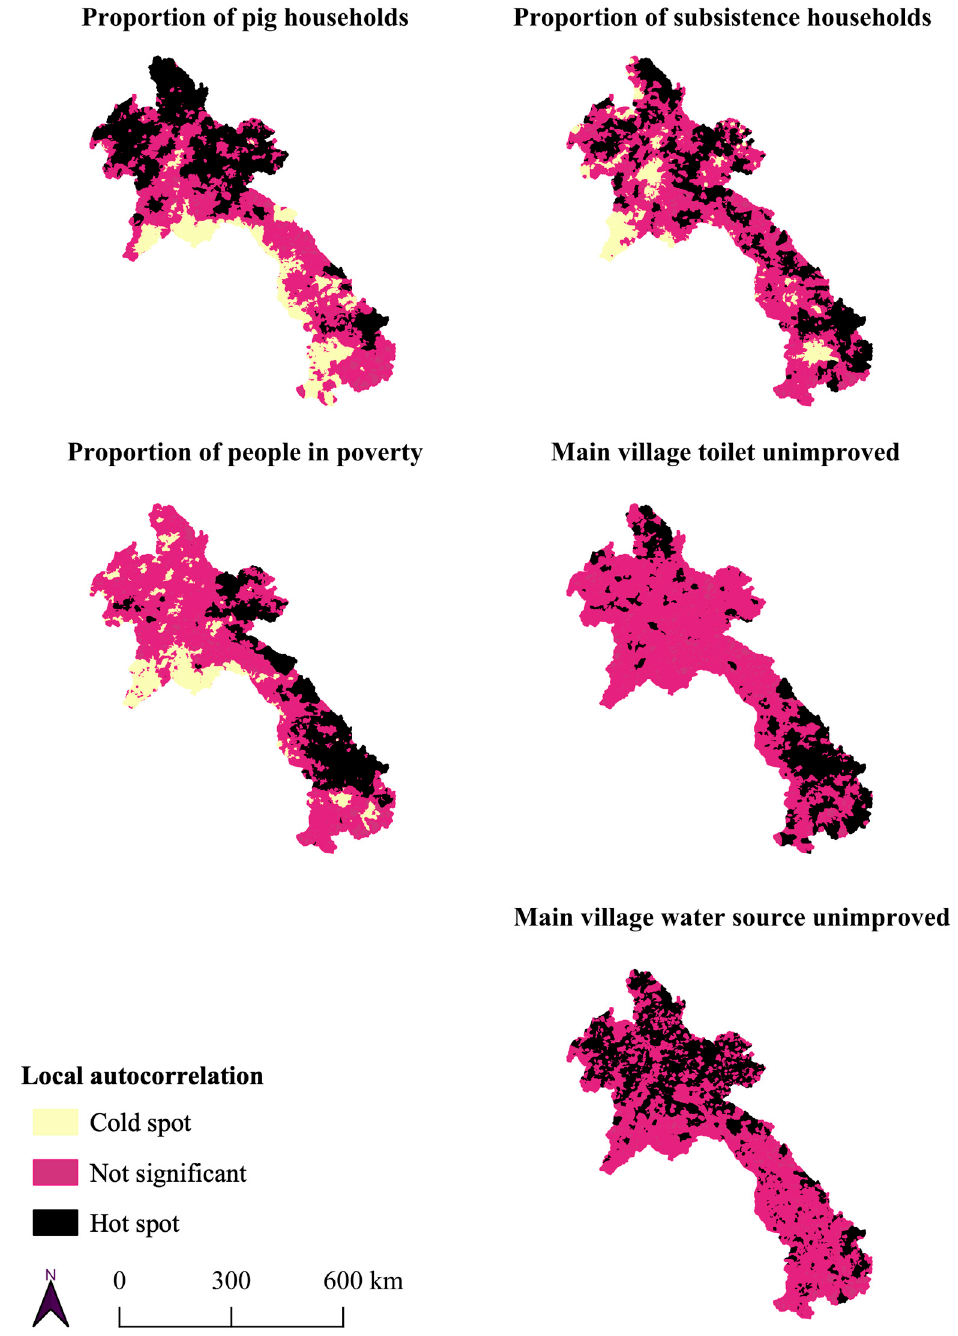
Figure 1. Mapping of local autocorrelation statistics. The co-occurrence of risk factor hot spots was present in approximately one in three villages (31%) (Table 3). This percentage decreased when considering only pig hot spots and the co-occurrence of other risk factors. One in five villages (20%) was classified as a hot spot for pigs and another risk factor (Table 3). Mapping these villages revealed northern Lao PDR as the largest area with overlapping hot spots for pigs and other risk factors. However, there was a smaller area in southern Lao PDR where villages were considered hot spots for almost all risk factors (Figure